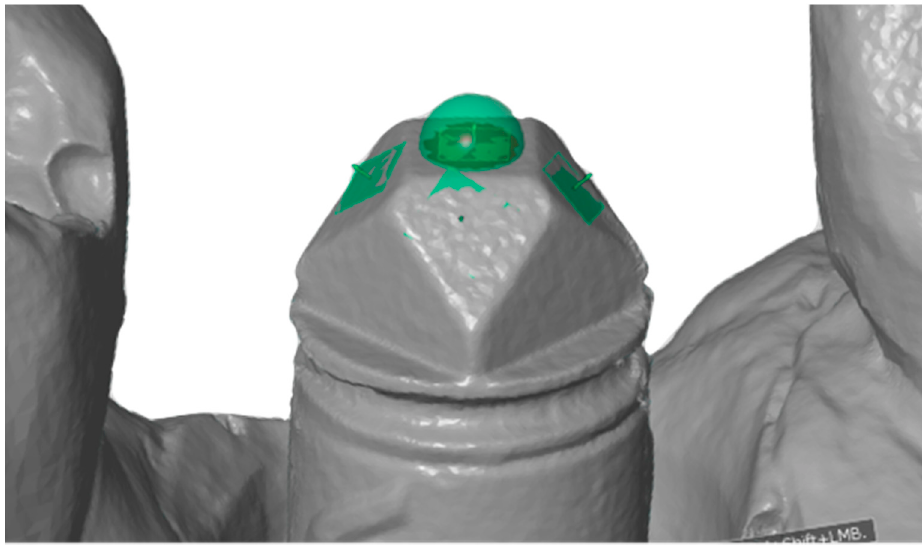
Figure 2. Surface topography measurement on the top surface on the scanbody.